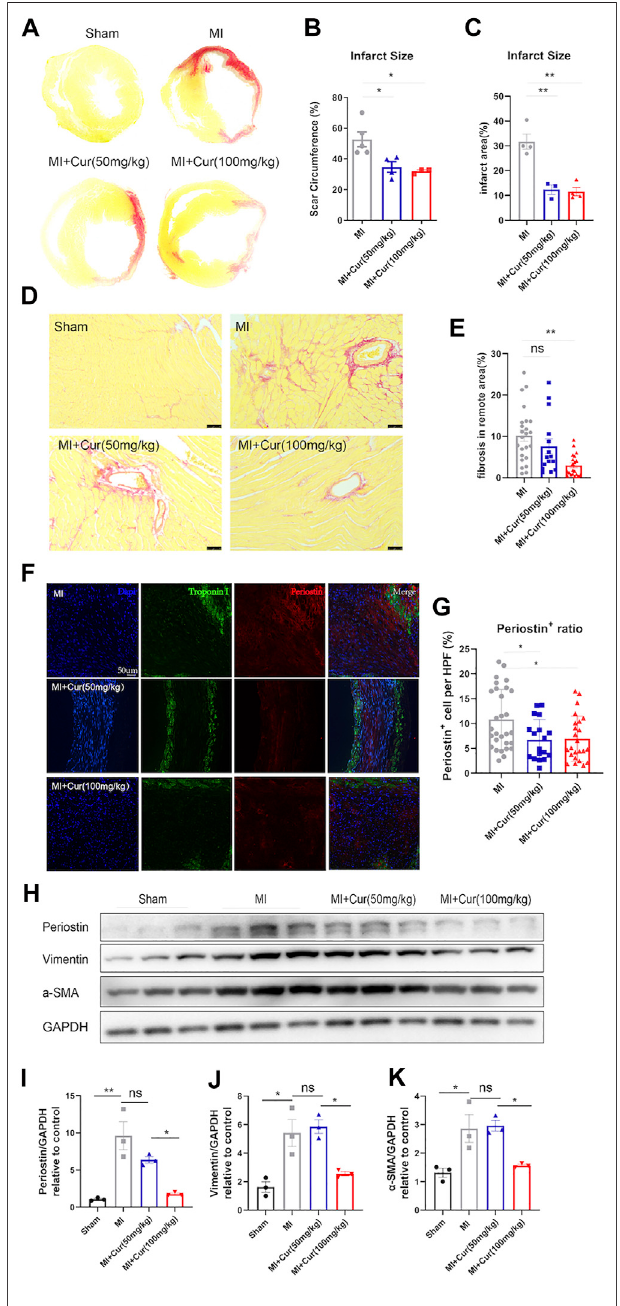
FIGURE 2 | Curcumin reduces scar formation and ameliorates adverse cardiac remodeling in post-MI rats in long-term prospects (A-B) . Representative images of sirius red staining of whole heart cross section in rat heart from all groups, as indicated (A) (B) Statistical analysis of scar circumference in each group (means with SEM). n (cid:1) 3 – 5 per group (C) Statisticalanalysisofinfarct areain each group(means withSEM). n (cid:1) 3 – 5per group (D-E). Sirius red staining of non-infarcted area in all groups (Sham, MI, MI + Cur 50 mg/kg, MI + Cur 100 mg/kg), scale bar (cid:1) 100 μ m n (cid:1) 5 per each group (D) . Collagen summary and statistics are plotted in (E) (F-G). Collagen deposition and content within MI segments measured by Periostin + cells within MI segment; Periostin (red) indicates myo fi broblasts that secrete ( Continued )